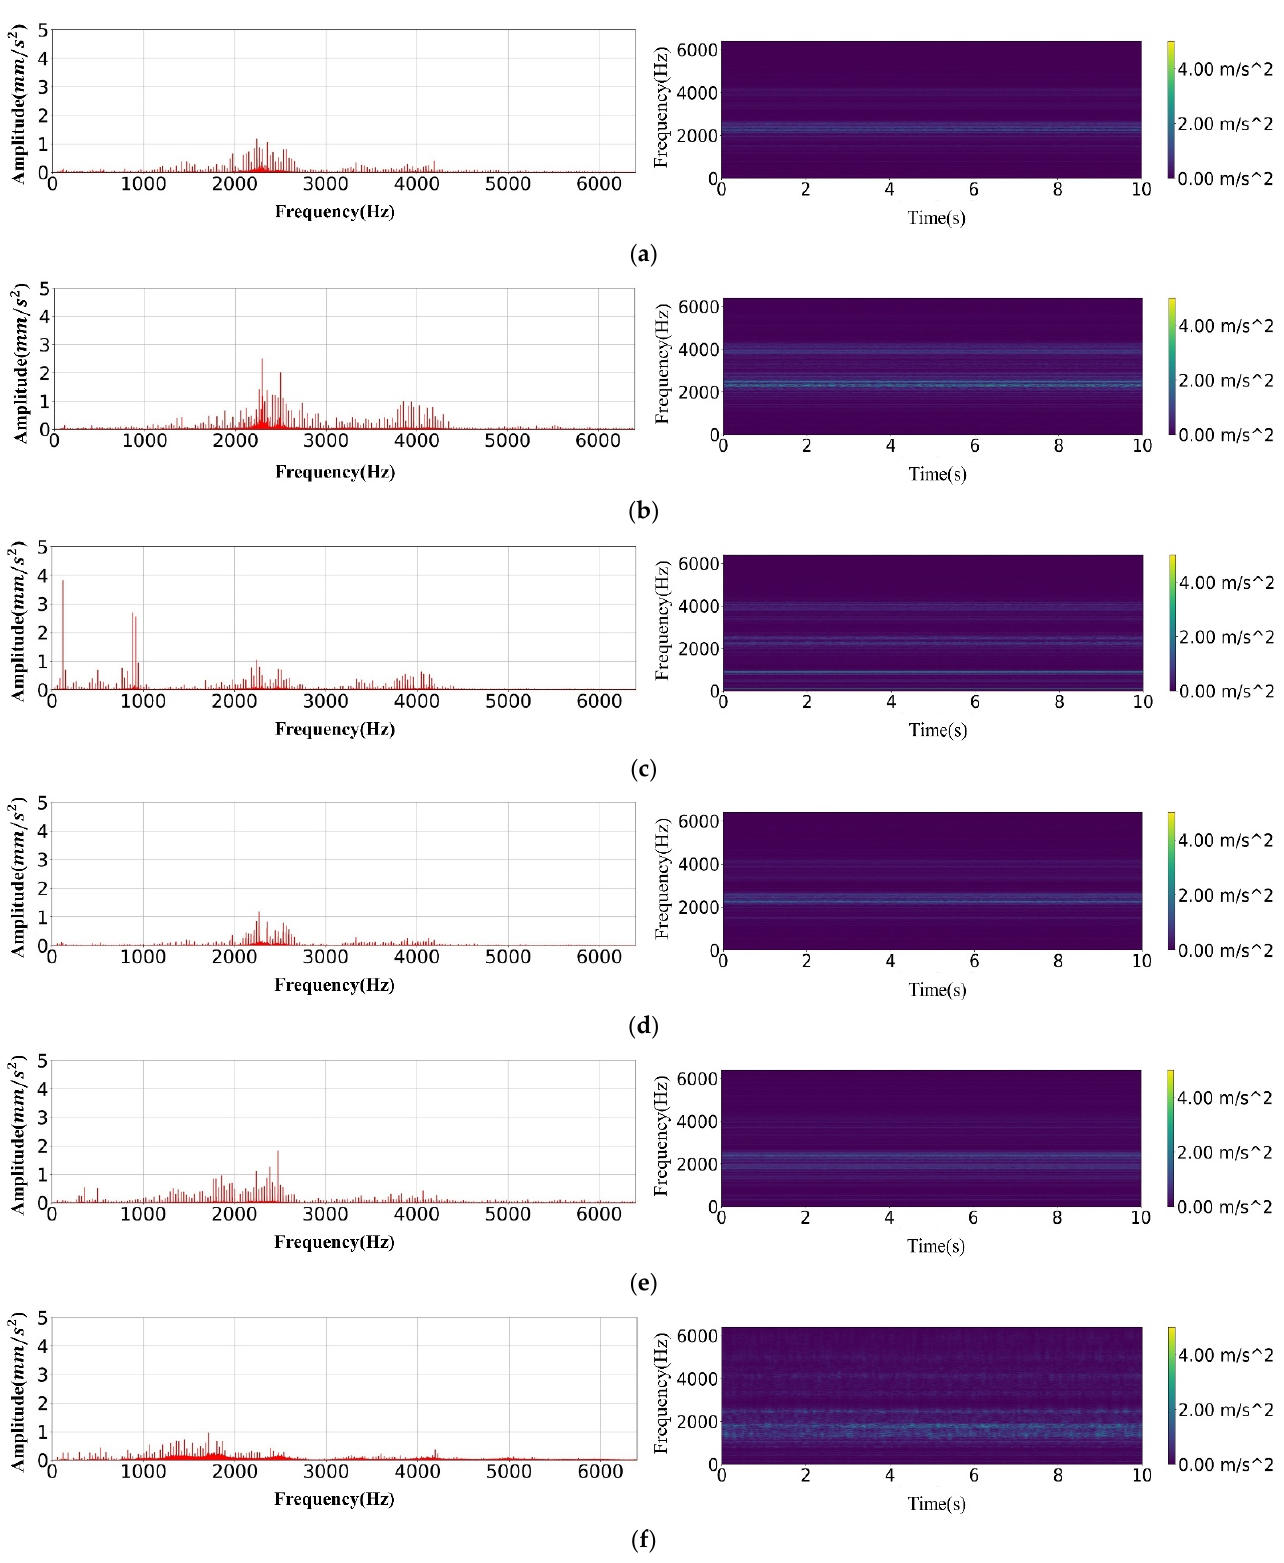
Figure 4. Graph of FFT and STFT of the vibration data: ( a ) Normal data; ( b ) Bearing particle injection test data; ( c ) Misalignment test data; ( d ) Jaw coupling elastomer test data; ( e ) Mechanical seal degradation test data; and ( f ) Cavitation test data